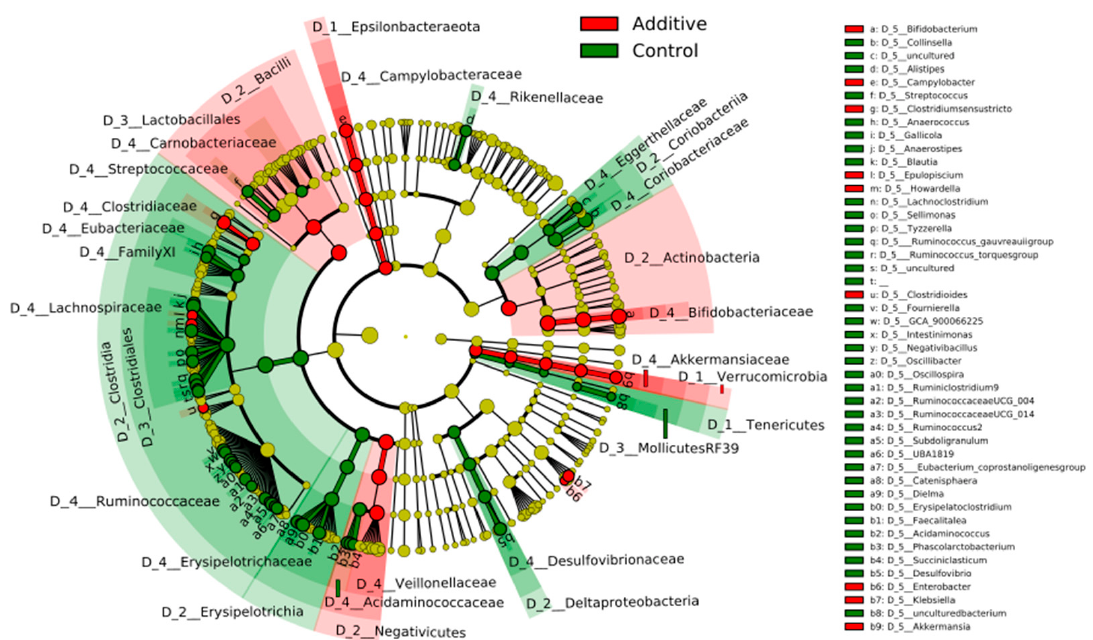
Figure 4. Cladogram reflecting statistically significant differences (calculated by LEfSE) of different taxa found in lamb feces between additive (red) and control (green) diets. Circles represent the different taxa in the different levels of taxonomy. From the inner to the outer circle—phylum (D_1), class (D_2), order (D_3), family (D_4), genus (D_5).